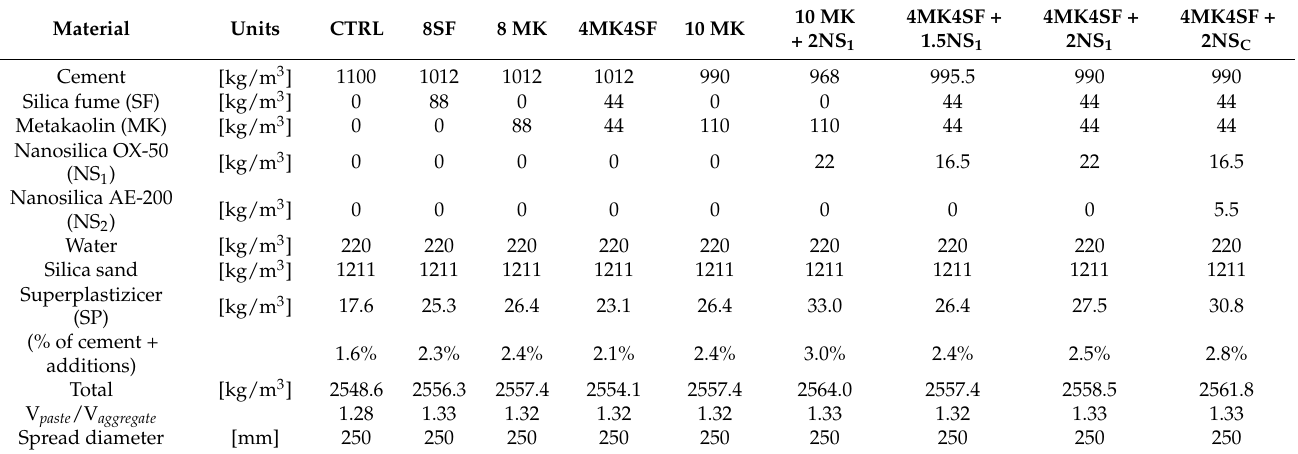
Table 2. Proportioning of UHPC